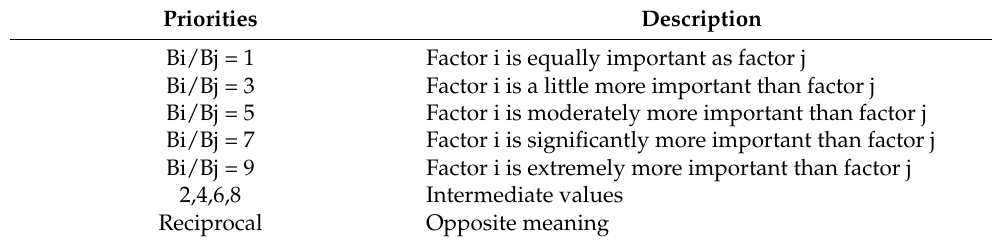
Table 2. Priorities of the two